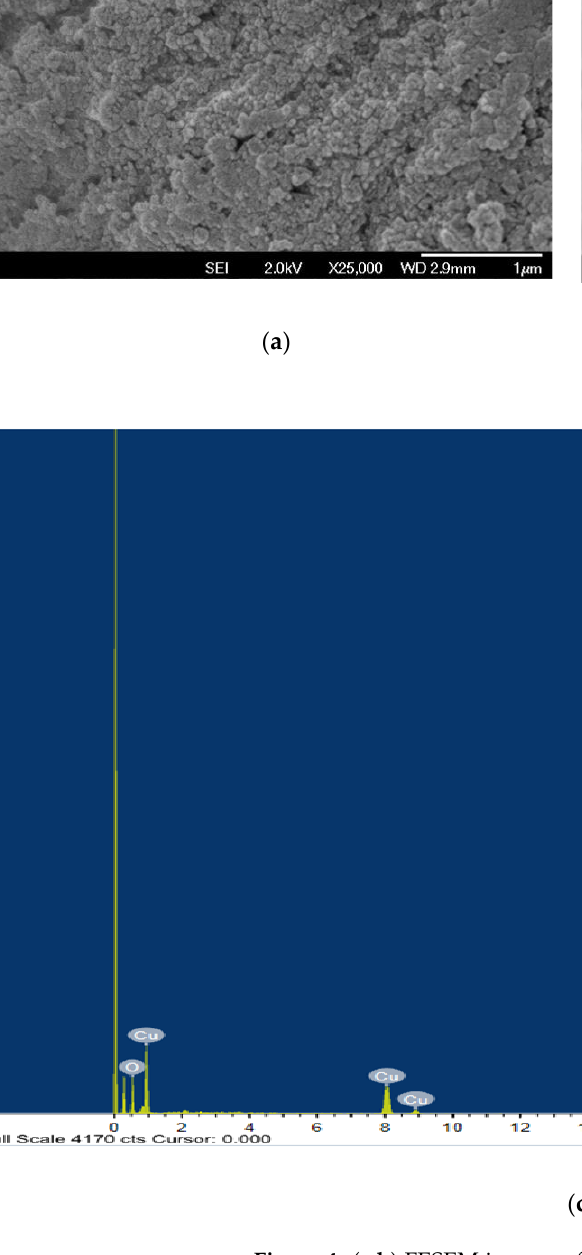
Figure 4. ( a , b ) FESEM images of bio- synthesized CuO nanoplates at different magnification and ( c ) Energy-Dispersive Spectroscopy (EDS) for Cu Nanoplates.